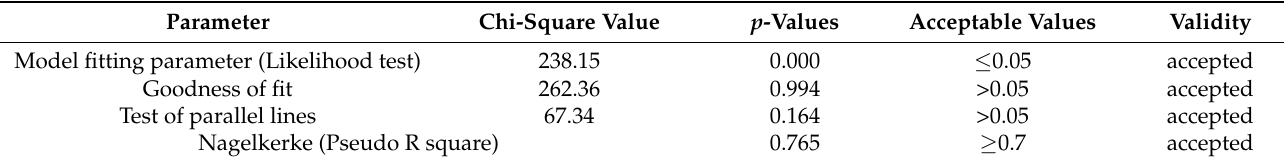
Table 4. Model validation